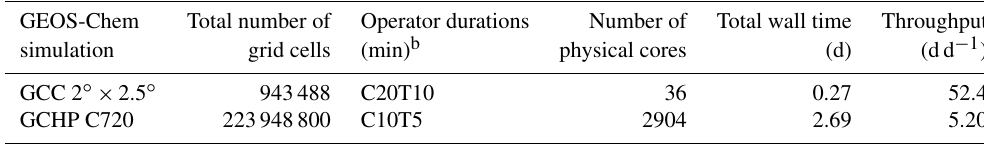
Table 5. Characteristics of GCHP and GEOS-Chem Classic (GCC) simulations a in Fig. 7. GEOS-Chem Total number